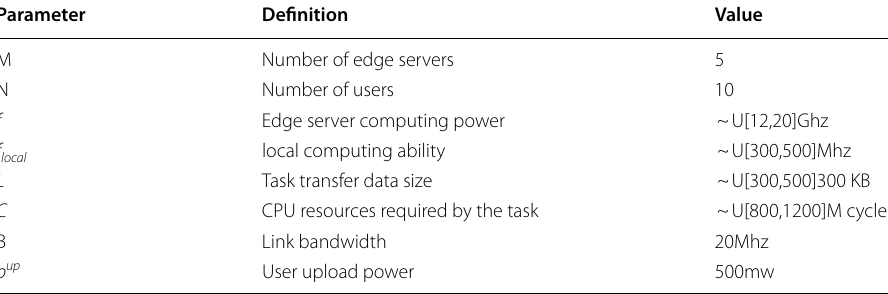
Table 2 Simulation parameter setting